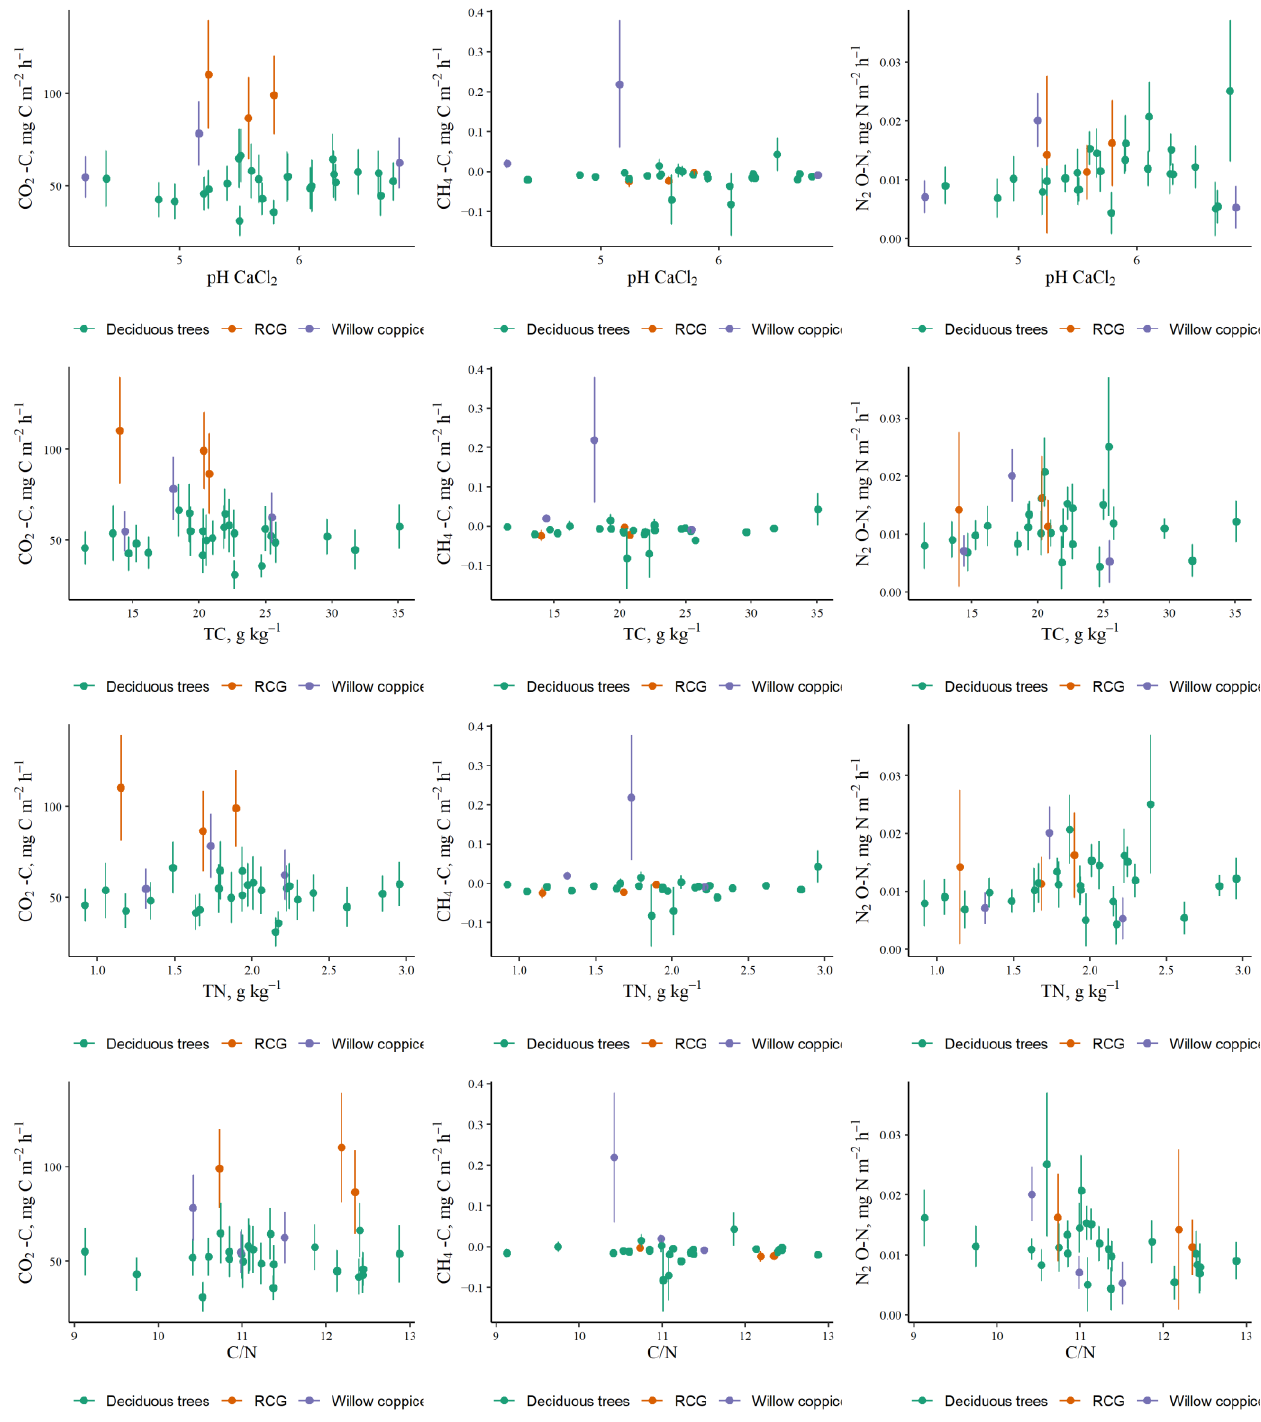
Figure 4. Impact of soil (at 0–5 cm depth) general chemistry on mean soil GHG fluxes in plots dominated by deciduous trees, willow coppice, or RCG in agroforestry systems in hemiboreal Latvia.